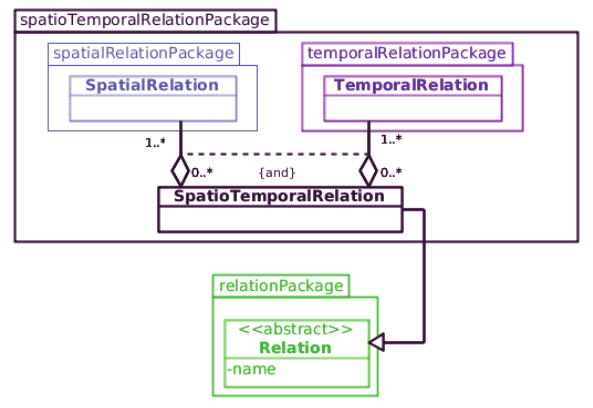
Figure 9: Spatiotemporal relation package.